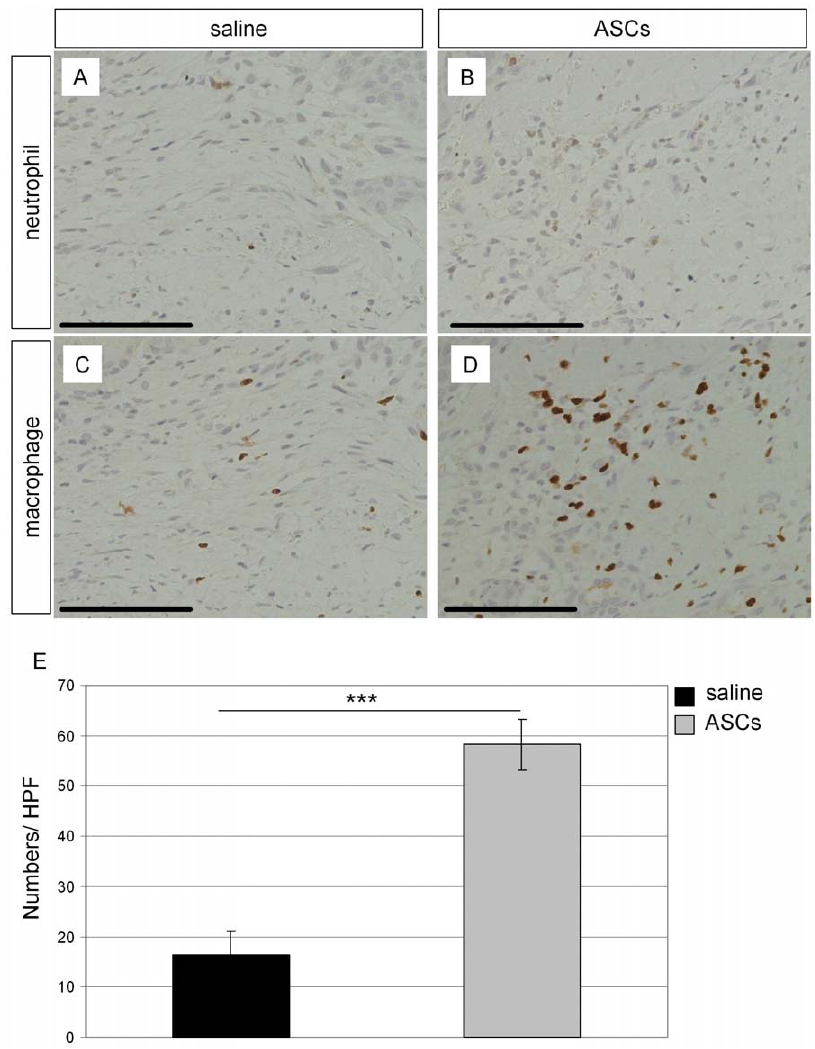
Figure 7. Higher infiltration of macrophages was found in ASCs treated wounds. Saline control (A, C) and ASCs (B, D) were delivered to wounds and harvested as described in Figure 3. Neutrophils (A, B) and macrophages (C, D) were visualized by DAB after staining with their specific antibodies. Scale bars: 100 m m. (E): Number of macrophages per high-power microscopic fields (HPF) at 400 X magnification. Macrophages were counted and averaged from four HPF. Data are from four independent wounds and presented as mean + SEM. ***p , 0.001. (PDF)